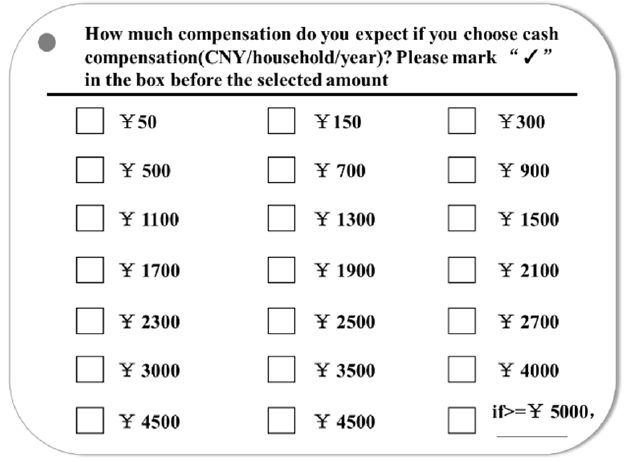
Figure 2. Payment Card questionnaire. Table 2. Sources of sample data.